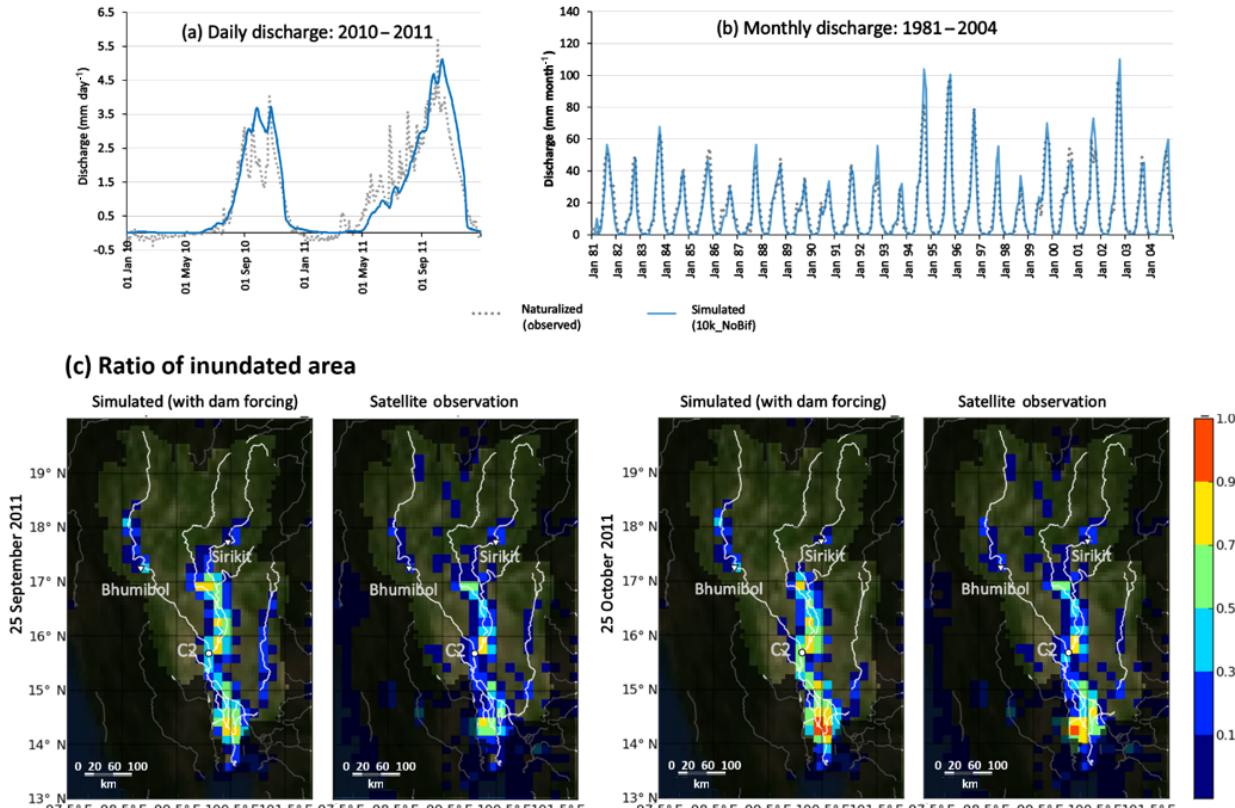
Figure 3. Validation of SDC simulation at 10km resolution. The simulated (a) daily discharge for the years 2010–2011 and the (b) monthly discharge from 1981–2004 were compared with the naturalized observed discharge. The (c) ratio of inundated area in 25 September 2011 and 25 October 2011 were compared with satellite data. Dam forcing indicates the simulations constrained using actual dam outflows as boundary conditions. All figures were modified from Mateo et al.